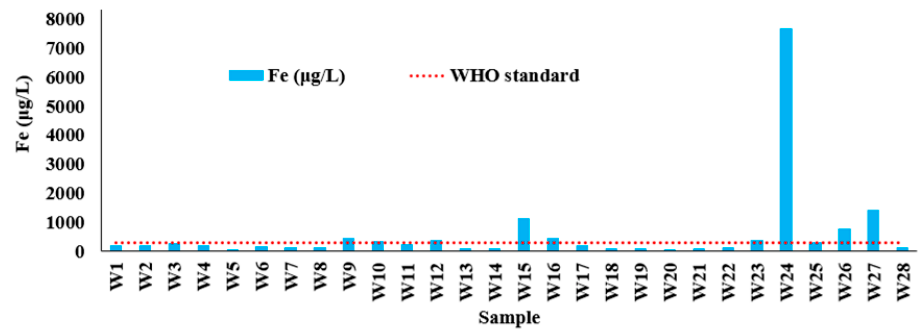
Figure 3. Excessive contaminants at the observation wells of the study area.